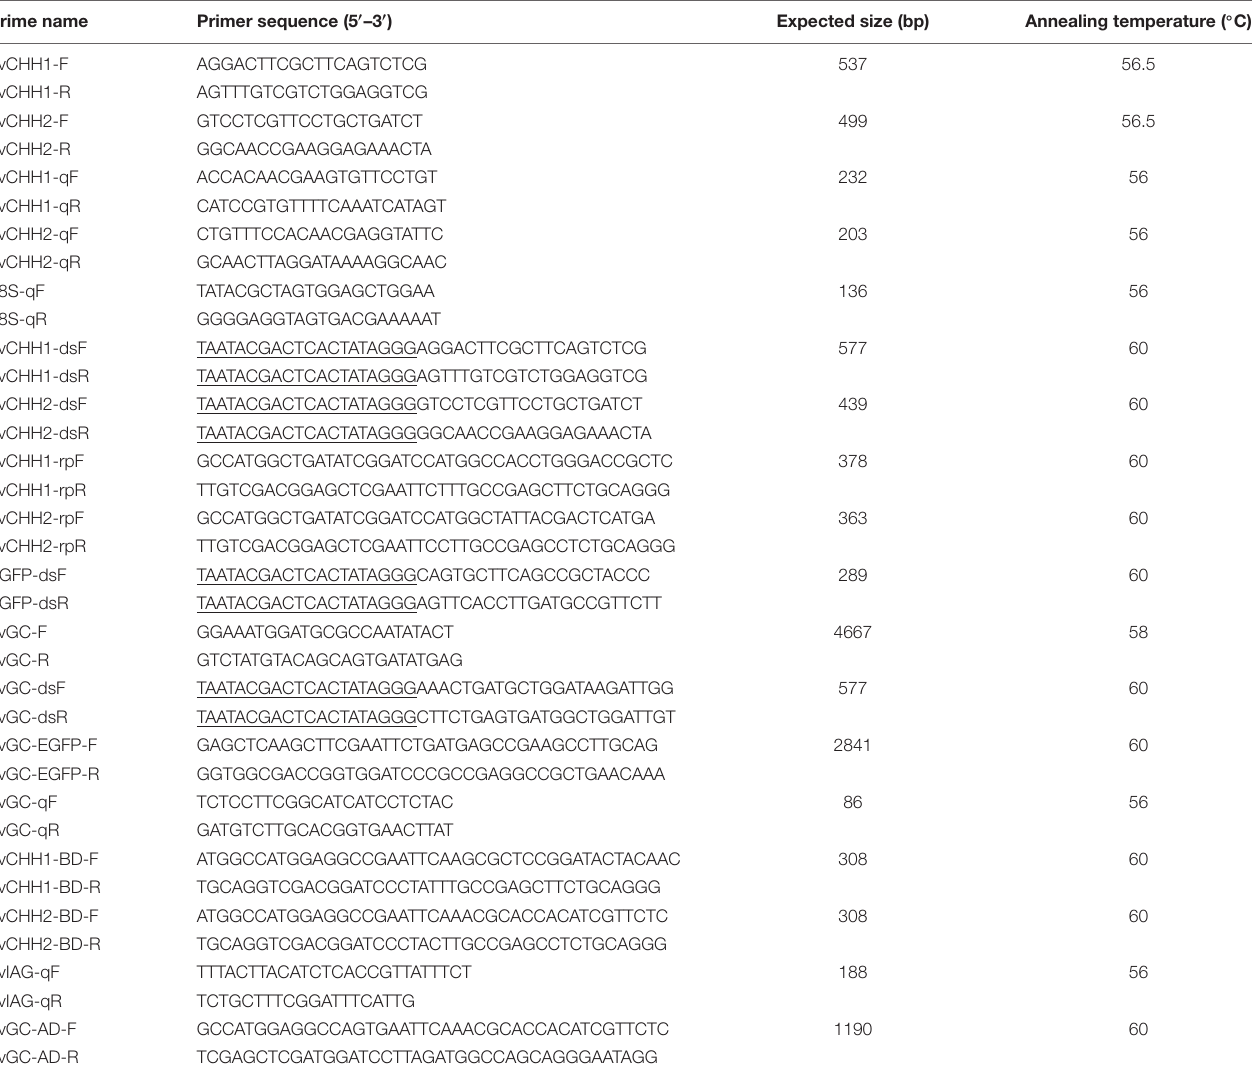
TABLE 1 | Primer sequences and corresponding annealing temperature of